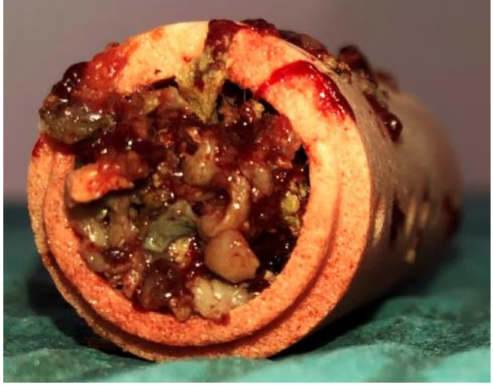
Figure 3. Shows a ß-TCP ceramic scaffold after intraoperative augmentation with cell-tissue compos- ite (EFRE-Projekt Boneflo, Department of Orthopaedics and Trauma Surgery University of Duisburg- Essen,